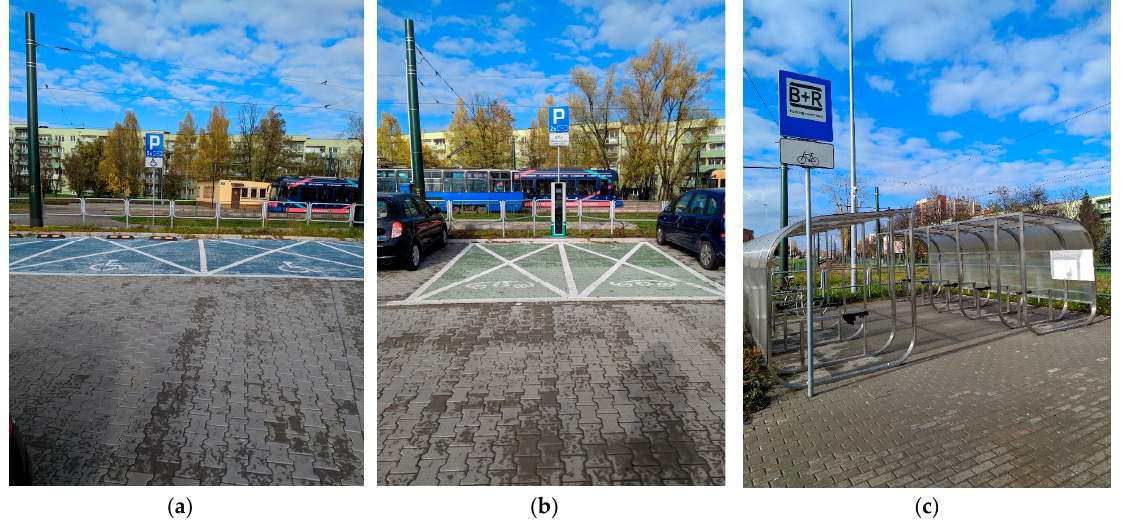
Figure 5. Examples of offered parking spaces in the P&R parking Bie ż anów in Cracow: ( a ) parking